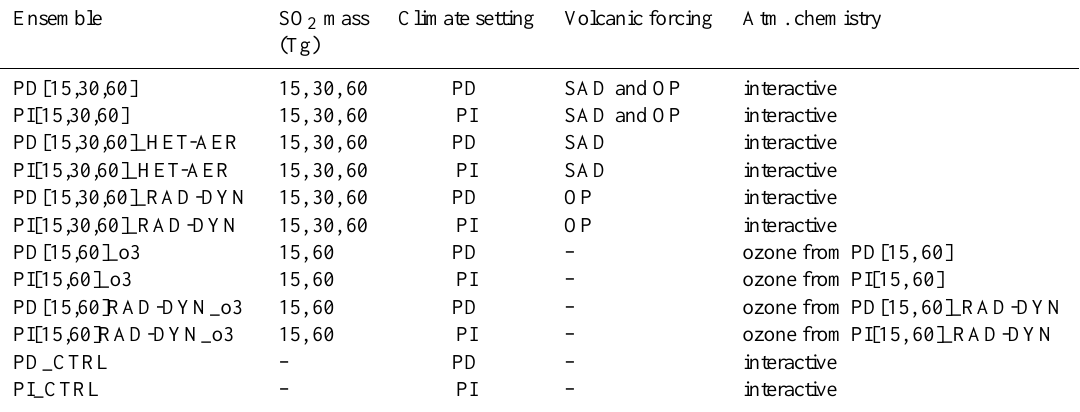
Table 1. Overview of the ensemble experiments used in this study. SO 2 mass refers to the aerosol amount assumed in the generation of the volcanic forcing (compare Sect. 2.2). Climate setting – PD: 1990s conditions with high concentrations of ozone depleting substances (ODS). PI: preindustrial atmosphere with low concentrations of ODS. Volcanic forcing – SAD: surface area density of the aerosols. OP: optical properties, i.e. extinction rates for all spectral intervals. For each ensemble, eight simulations are performed. Ensemble SO 2 mass